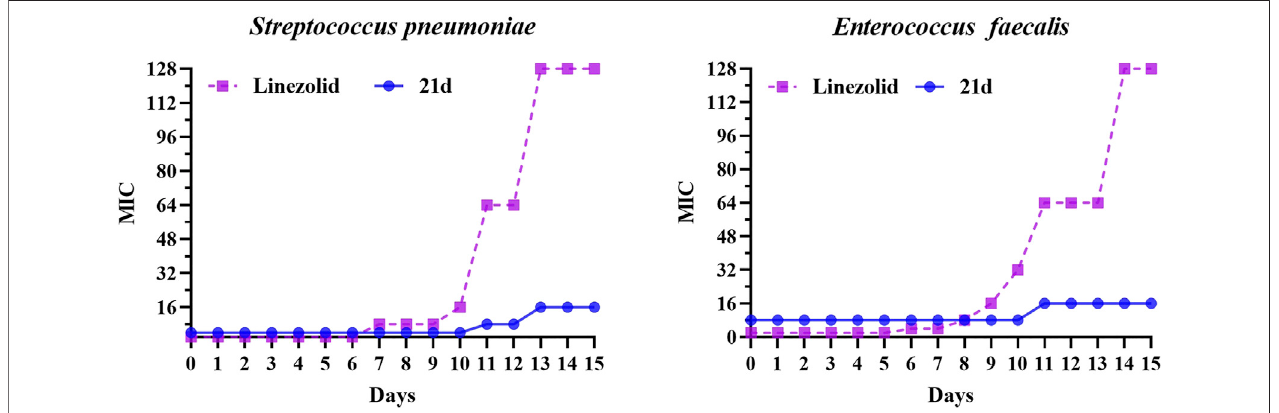
FIGURE 8 | The MIC variability of 21d and linezolid against S. pneumoniae (ATCC 49619) and Enterococcus faecalis (ATCC 29212) during 15 days of the resistance development assay, with linezolid as a